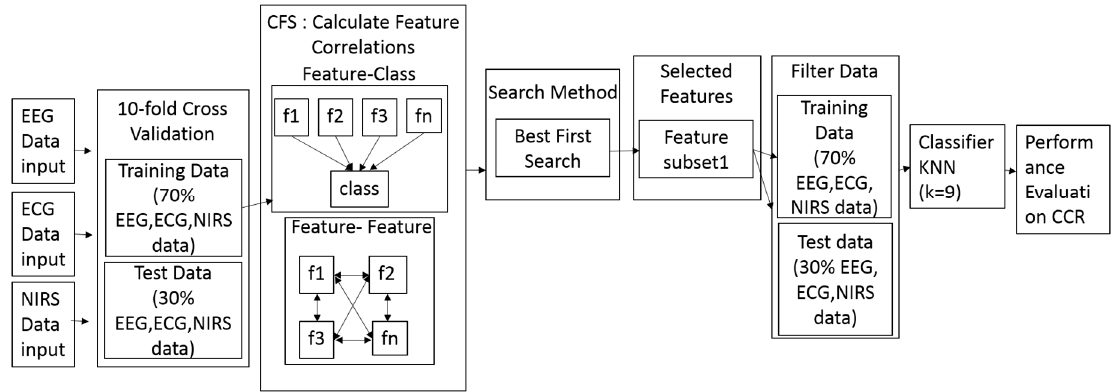
Figure 6. The flowchart of predictive modeling using a CFS and KNN combination (CFS + KNN) method.